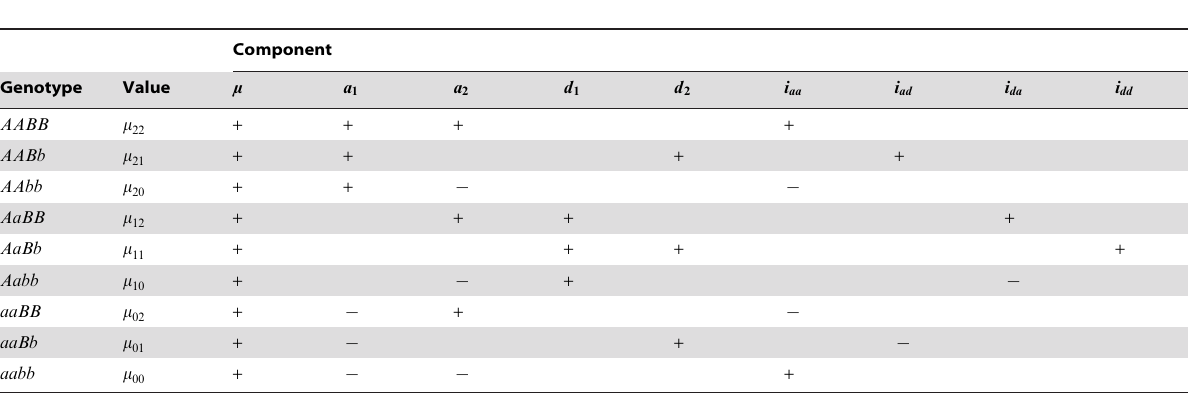
Table 1. The genetic effect components of two-locus